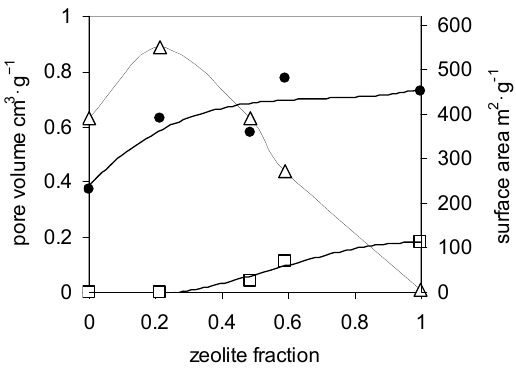
Figure 4. Texture of chitosan and composite aerogels vs. zeolite content. Mesopore (void triangles) and micropore (void squares) volumes (left side Y axis) and surface area (filled circles, right side Y axis). The lines are guides for the eye.